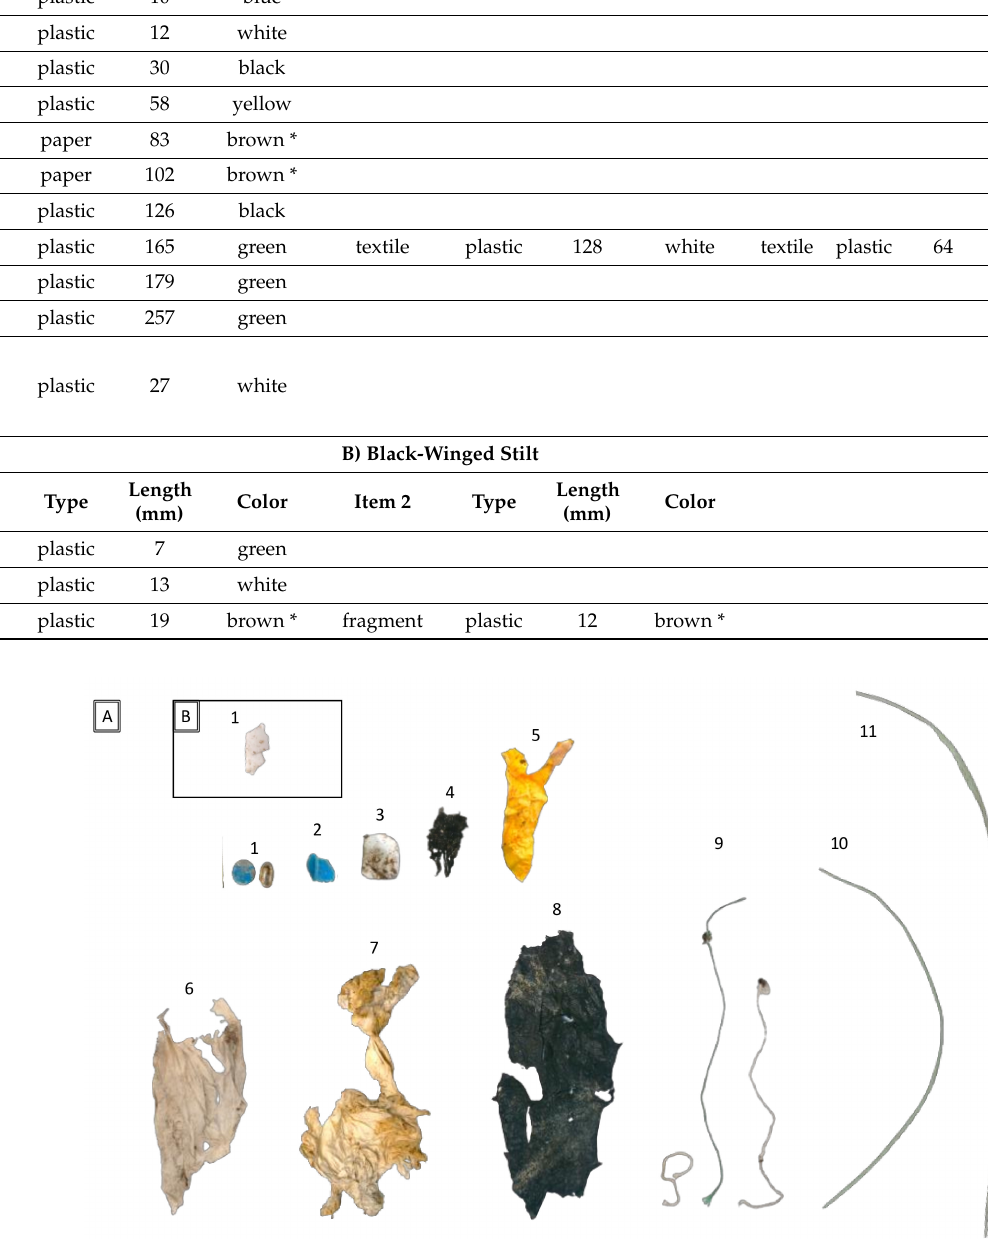
Figure 2. Anthropogenic debris collected in the gull-billed tern ( Gelochelidon nilotica ) nests from two breeding colonies ( A , B ) in the La Mancha H ú meda Biosphere Reserve. Each number corresponds to a different nest. Additional information about each item is provided in Table